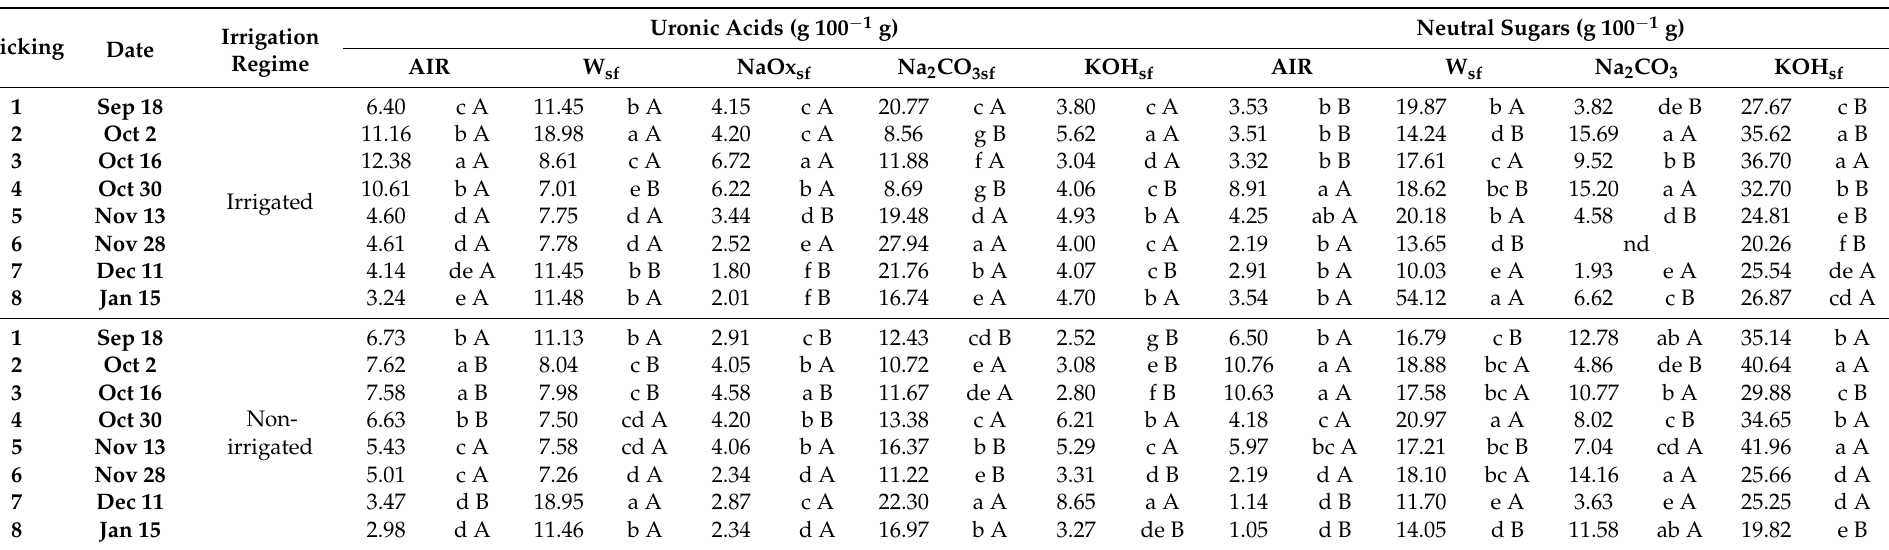
Table 3. Uronic acid and neutral sugar contents in AIR and in AIR fractions recovered during fruit ripening of irrigated and non-irrigated ‘Arbequina’